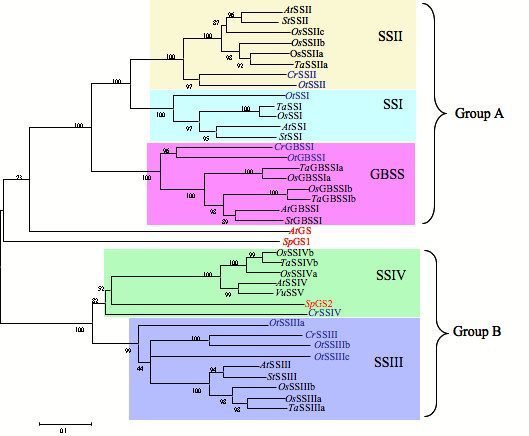
Phylogenetic tree showing the relationship between plant and algal SS and prokaryotic GS isoforms on the basis of predicted amino acid sequence. The tree was constructed using the neighbour-joining method and confidence limits to branch points in the tree were assigned by bootstrapping the alignment with a random number generator seed of 111 and 1000 trials. Unicellular algae SSs are shown in blue and GSs are in red. Each node is labeled with the prefix of the initials of the genus and species, e.g. At = Arabidopsis thaliana Agt = Agrobacterium tumefascien; Cr = Chlamydomonas reinhardti; Sp = Synechocystis; Os = Oryza sativa;, Ot = Ostreococcus tauri; St = Solanum tubersum; Ta = Triticum aestivum; and Vu = Vignia unguiculata; Genbank accession numbers of the starch synthases and glycogen synthases shown in the tree are as follows: AtSSI [AAF24126], AtSSII [AAF26156]AtSSIII [AAD30251], AtSSIV [CAA16796], AtGBSSI [NP_174566], CrGBSSI [AAL28128], CrSSII [AAC17970], CrSSIII [AAY42381], CrSSIV [AAC17971], AgtGS [AAD03474], OsGBSSI [AAC61675], OsSSI [AAL16661], OsSSIIa [Q5DWW9], OsSSIIb [AAK81729], OsSSIIc [AAK64284], OsSSIIIa [AAM49811], OsSSIIIb [AAL40942], OsSSIVa [AAQ82622], OsSSIVb [AAQ82623], OsGBSSI [AAF72562], OsGBSSIb (called GBSSII [BAF26592]) SpGS-1 [P74521], SpGS-2 [P72623], StSSI [P93568], StSSIII [T07663], TaGBSSI [BAA77351], TaSSI [CAB99209], TaSSIIa [CAB86618], TaSSIIIa [AAF87999], TaSSIIIb [ABY56823]TaSSIV [AAK97773], VuSSIII [CAB40374], VuSSV [CAB40375], TaGBSSII [AAF14233], OtSSI [CAL56451], OtSSII [CAL58277], OtSSIIIa [AAS88893], OtSSIIIb [AAS88894] and OtSSIIIc [AAS88881].